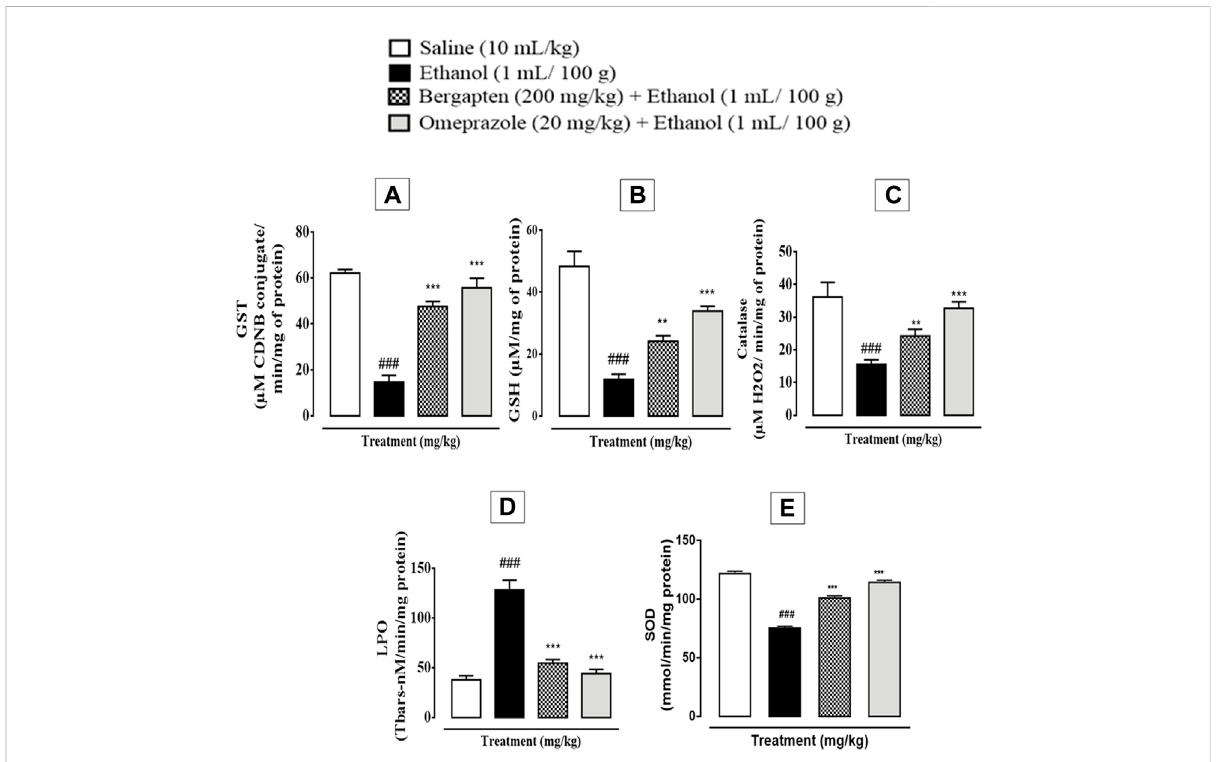
FIGURE 8 Effect of bergapten (200 mg/kg) and omeprazole groups against (A) glutathione-S-transferase (GST), (B) glutathione (GSH), (C) catalase, (D) lipidperoxidation(LPO),and (E) superoxidedismutase (SOD)intheethanol-inducedgastriculcermodel. Thedataareexpressedasmean±SEM( n = 3), and analyzed by one-way ANOVA with post hoc Tukey ’ s test. ### p < 0.001 vs. saline group, *** p < 0.001, ** p < 0.01 vs. ethanol